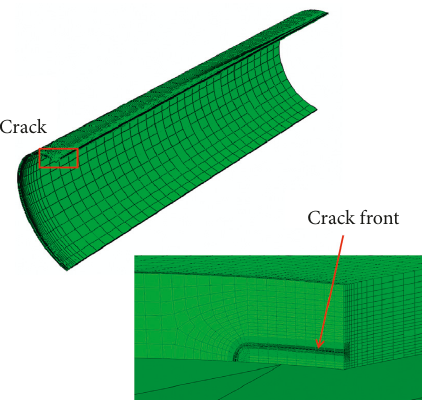
Figure 2: Finite element mesh for the pipe with a / t and D / t (cid:31)